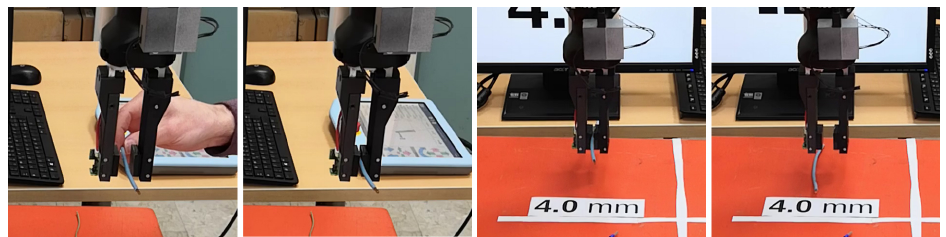
Figure 10. Some frames taken from the video of the sorting task.